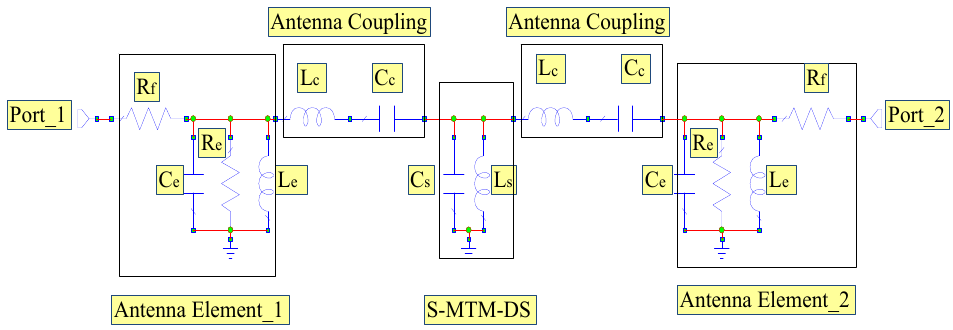
Figure 7. Slotted MTM-DS antenna array equivalent circuit.